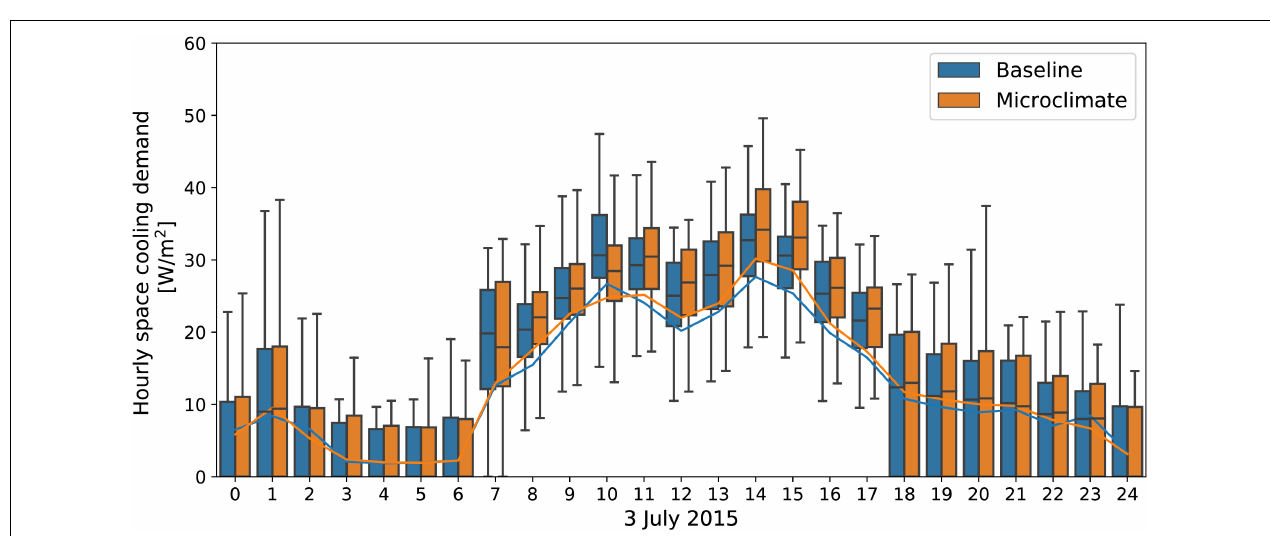
FIGURE 11 | Box plots showing the change in space cooling demand and peak cooling power on the selected day when replacing the weather station data with simulated local microclimate results. The total space cooling demand comprises the sensible and latent demands.